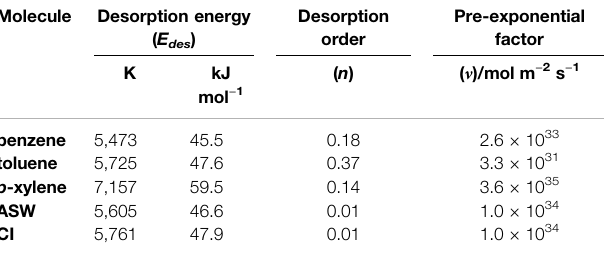
TABLE 2 | Kinetic parameters derived from experimental data and used in the model for astrophysical ices. Parameters for benzene, toluene and p -xylene are those reported by Salter et al. (2018) and ASW and CI are those reported by Fraser et al. (2001). Molecule Desorption energy ( E des )